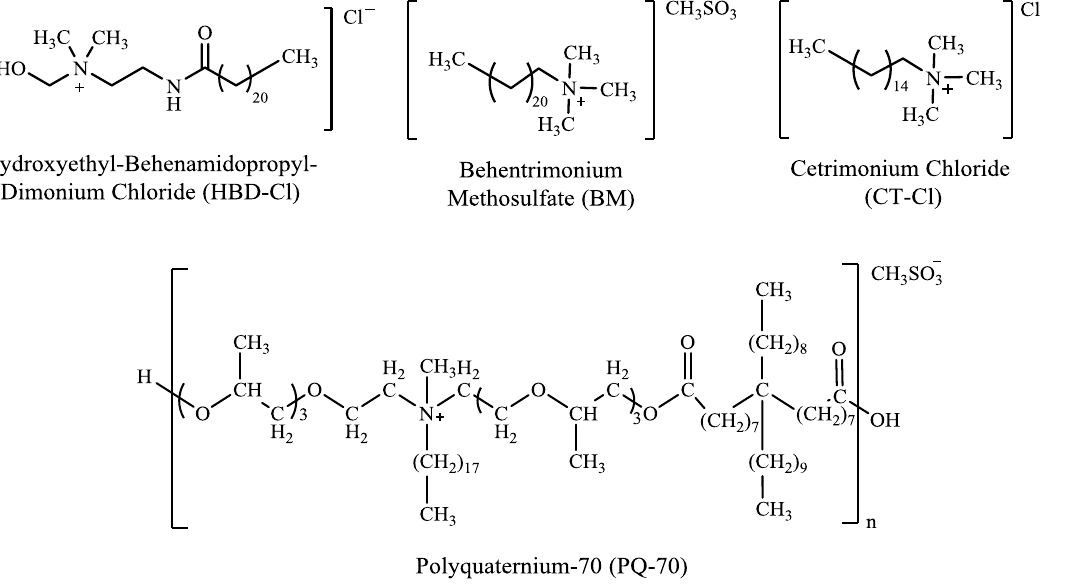
Figure 1. Chemical structures of cationic surfactants used in the study.